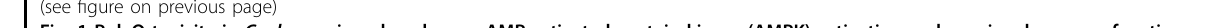
le 1: Fig. S1b), and induces neuronal toxicity, indicated